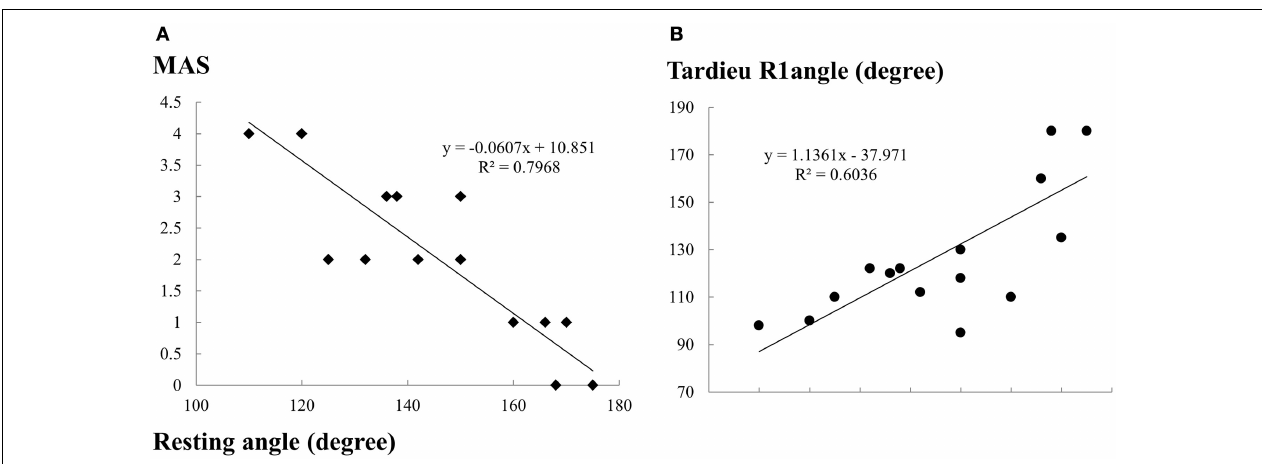
FIGURE 4 | Correlations between the resting angle and clinical measurements (A) MAS and (B) Tardieu R 1 angle . Because of same measures for some cases, there are less data points (cases) on the figure than the actual number of cases. Refer to Table 1 for